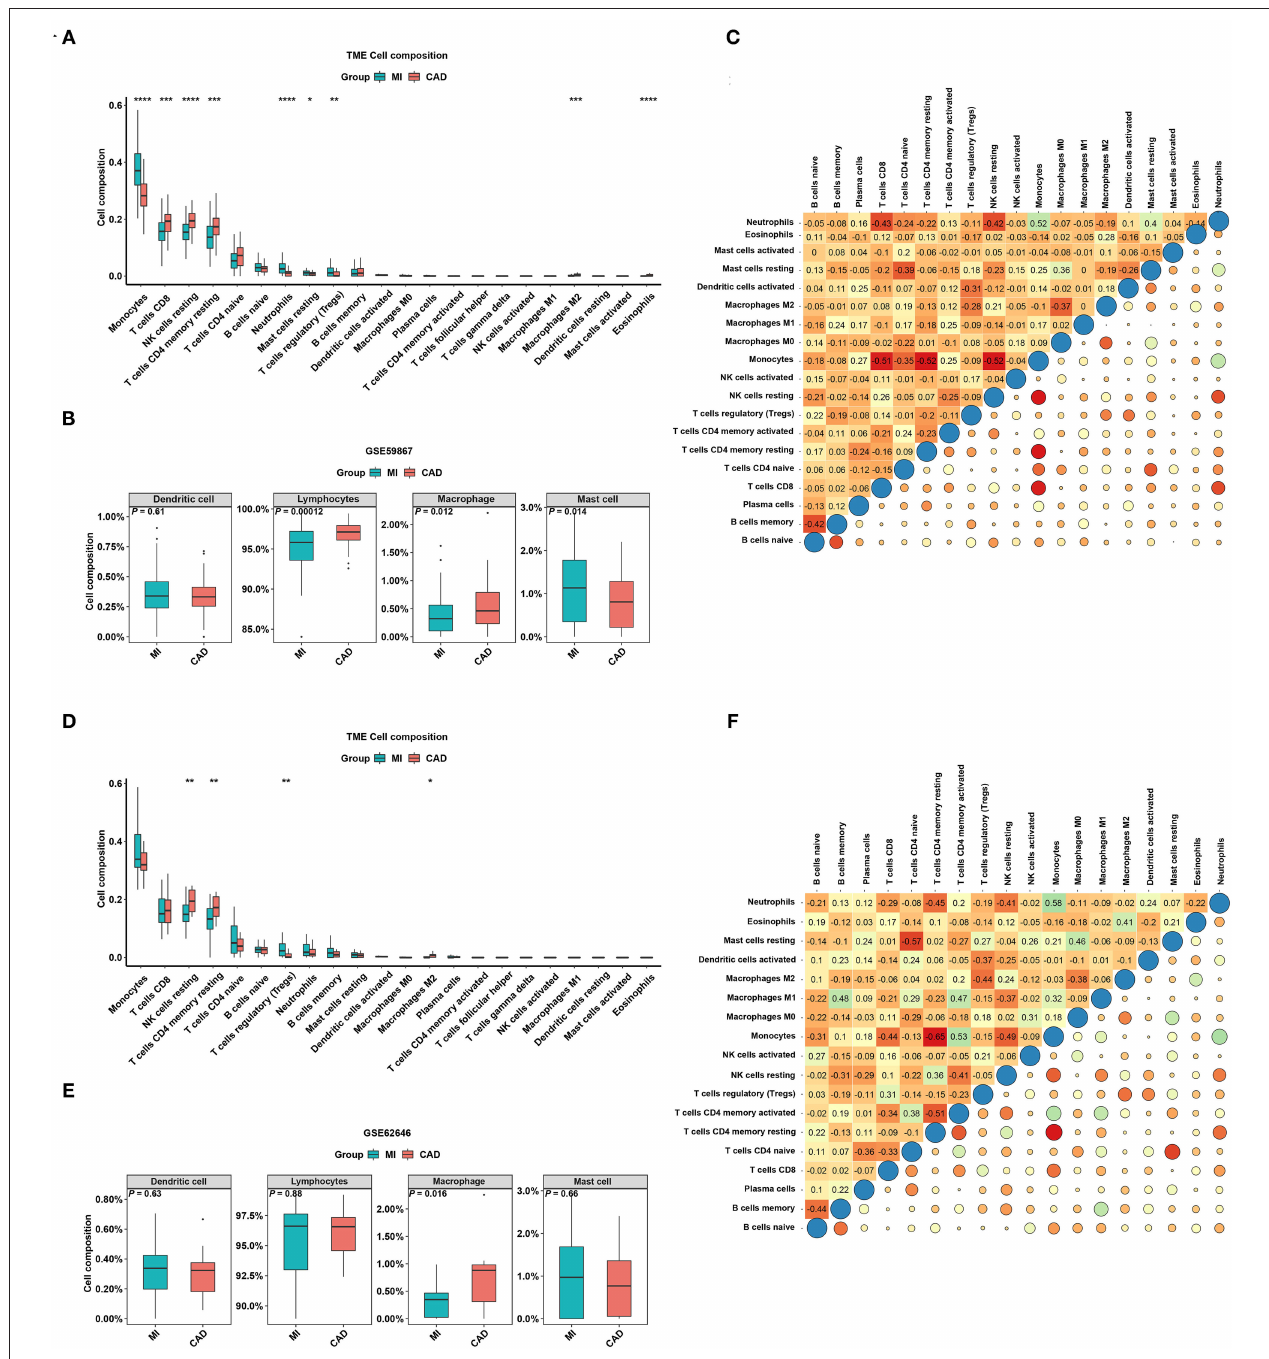
FIGURE 5 | The distribution of 22 types of immune cells between the MI and CAD samples. (A,D) Violin plots of 22 types of immune cells that are differentially enriched in the (A) GSE59867 dataset and (D) GSE62646 dataset. (B,E) Violin plot of four aggregated immune cell types that are differentially enriched in the (B) GSE59867 dataset and (E) GSE62646 dataset. (C,F) Heatmap of correlations for 22 types of immune cells in the (C) GSE59867 dataset and (F) GSE62646 dataset. The size of the colored squares represents the strength of the correlation. Darker color implies stronger association. * P < 0.05; ** P < 0.01; *** P < 0.001; **** P < 0.0001. with most genes related to NK cell markers (all P <